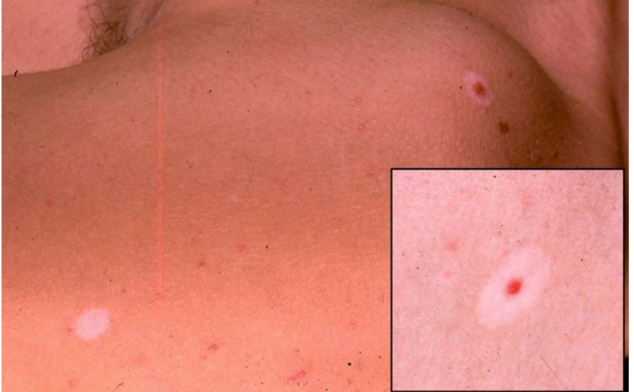
Figure 2. Halo nevus on lower abdomen and a white macule on the left as final ending of the regression phenomenon; in the magnification in the lower right portion of the image, the depigmented area surrounding the mole is more